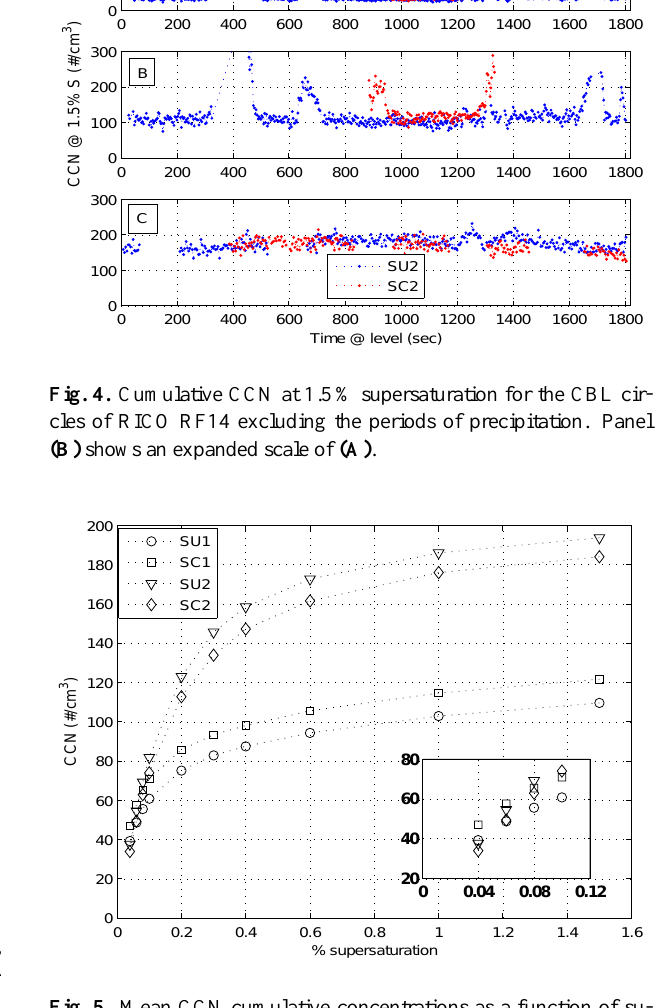
Fig. 5. Mean CCN cumulative concentrations as a function of su- persaturation from the four CBL circles for periods free of SO 2 pol- lution and